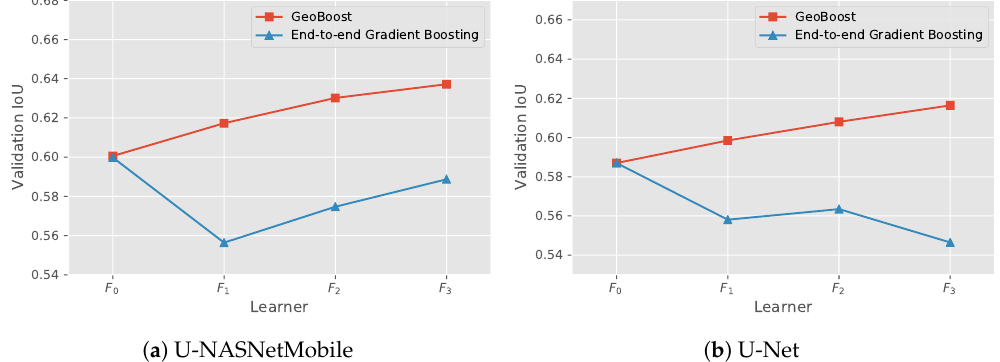
Figure 6. Accuracy variation of the GeoBoost models. The base learner of boosting is the U-NASNetMobile model for ( a ) and the U-Net model for ( b